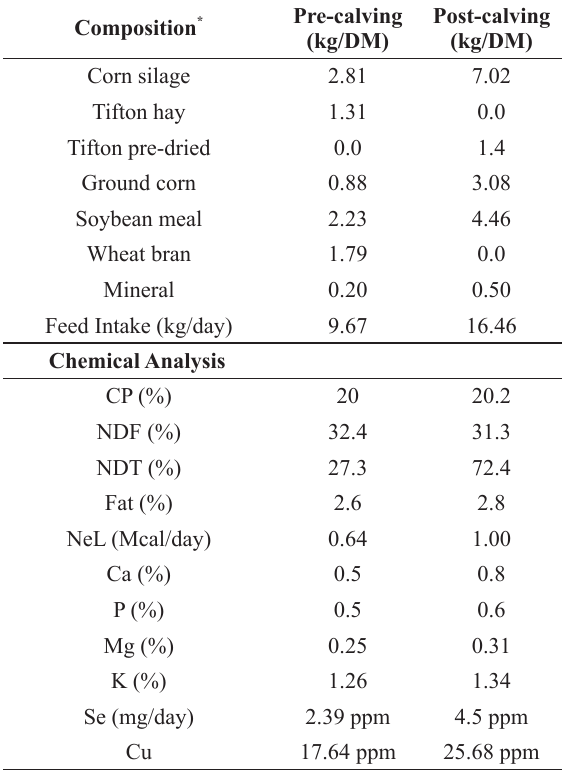
Ingredients and chemical composition of the experimental